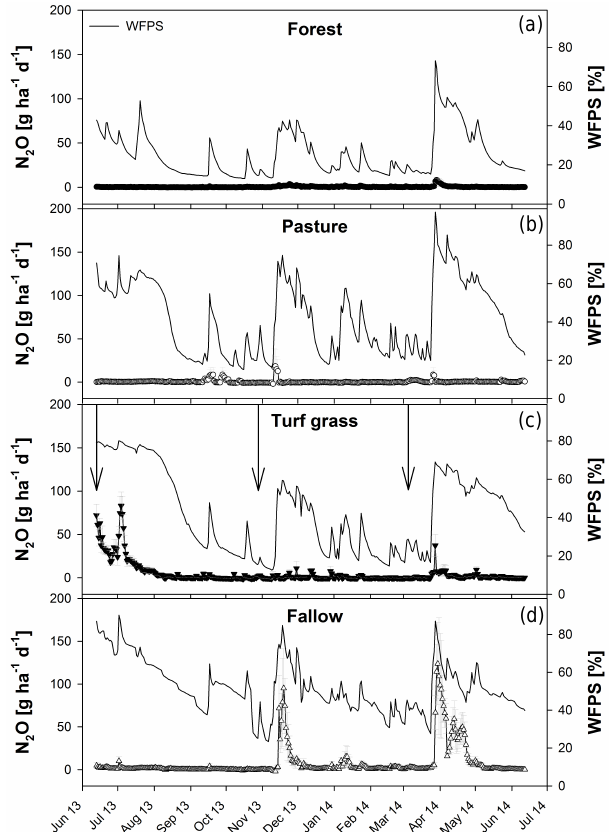
Figure 2. Daily N 2 O flux averages (max eight fluxes per day for three replicates each) with standard errors ( N = 3) over the exper- imental year 2013 / 2014 for forest (a) , pasture (b) , turf grass (c) , and fallow (d) with the treatment-specific water-filled pore space (WFPS).